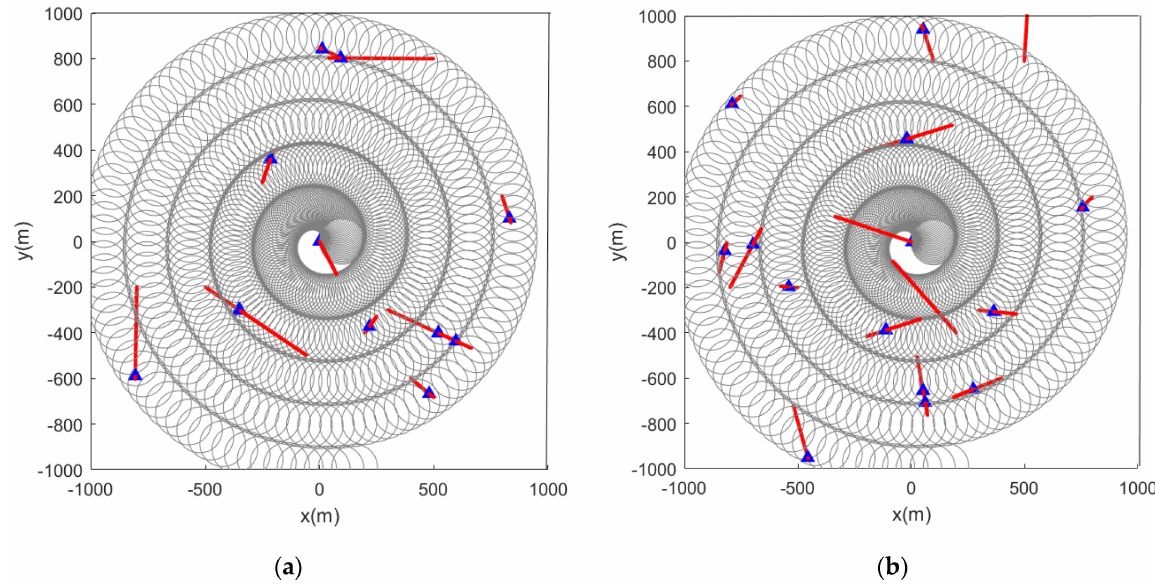
Figure 12. Estimated position of dynamic feature points using the LMB algorithm (the red track is the feature point motion track; the blue marks indicate the estimated positions of the feature points in the scene). ( a ) Sensor detection radius is 100 m and there are 10 feature points in the scene; ( b ) sensor detection radius is 100 m and there are 15 feature points in the scene.